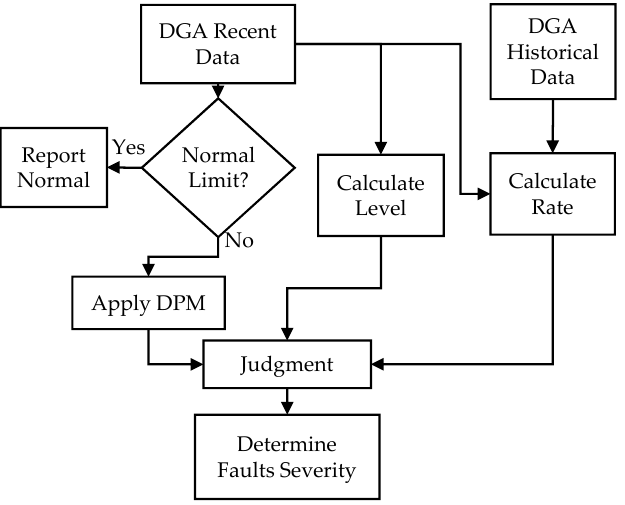
Figure 5. Flowchart of the proposed approach.